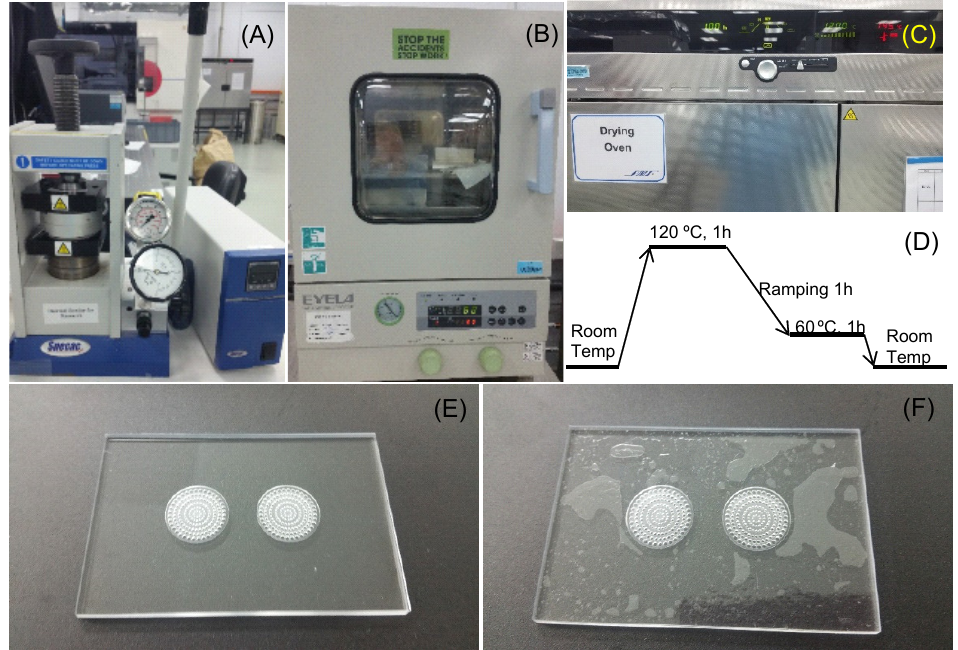
Figure 4. Thermo-bonding of VfB: ( A ) Thermo-bonding machine by hydraulic pressure. ( B ) Vacuum oven for surface dehydration. ( C ) High temperature oven for thermo-bonding. ( D ) Optimized bonding protocol in high temperature oven. ( E , F ) The finishing surface of thermo-bonded VfB with ( E ) and without ( F ) overnight vacuum oven dehydration. Scale bars = 1 cm.